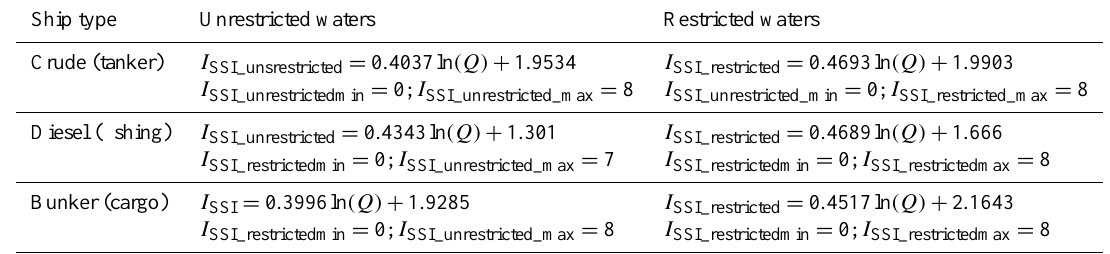
Table D3. Quantification of severity index of spill incident, based on oil amount ship type.